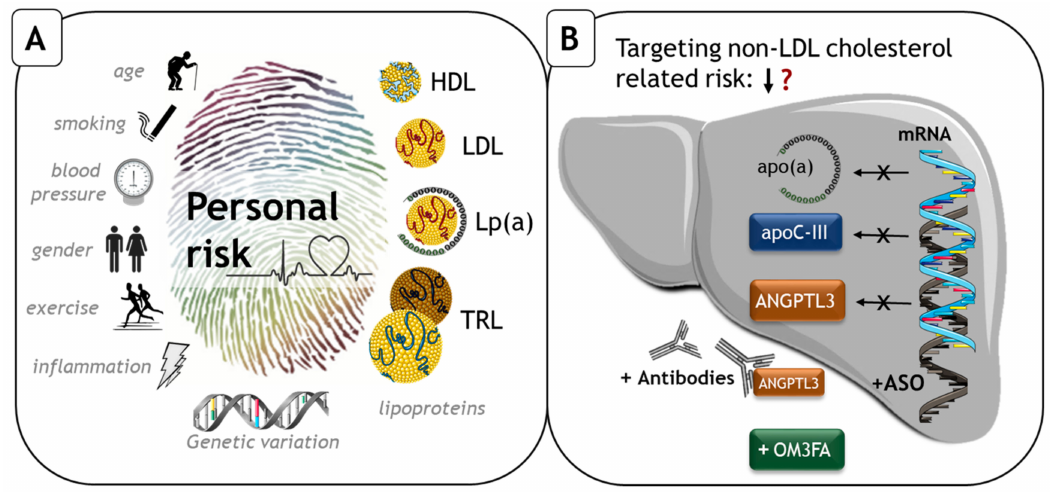
Figure 1. ( A ) Panel A summarizes the major factors associated with the risk of atherosclerotic cardiovascular disease (ASCVD). ( B ) Panel B shows strategies that are currently tested to reduce the risk beyond low-density lipoprotein (LDL) cholesterol lowering, which is the focus of this review. Apo(a), apoC-III and ANGPTL3 are all targeted with antisense oligonucleotides (ASO) which, after subcutaneousinjections, bindtotherespectivemRNAsinthelivertoinhibitproteinsynthesis. Following the successful introduction of monoclonal antibodies against PCSK9, antibodies against ANGPTL3 in the circulation are also tested. Finally, omega-3 fatty acids (OM3FA) are given as oral supplements to reduce triglycerides (TG) and inflammation. Abbreviations: HDL, high-density lipoprotein; LDL, low-density lipoprotein; Lp(a), lipoprotein (a); TRL, triglyceride-rich lipoproteins; mRNA, messenger RNA; Apo, apolipoprotein; OM3FA, omega-3 fatty